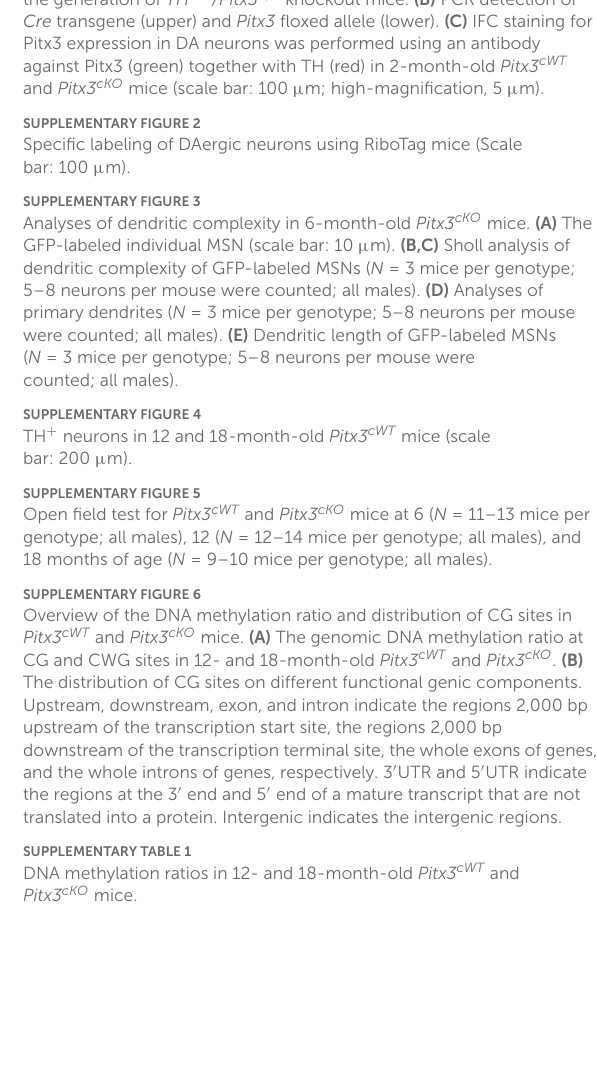
SUPPLEMENTARYFIGURE1 Conditional knockout of Pitx3 in DA neurons. (A) The basic strategy for the generation of TH Cre /Pitx3 fl / fl knockout mice. (B) PCR detection of Cre transgene (upper) and Pitx3 floxed allele (lower). (C) IFC staining for Pitx3 expression in DA neurons was performed using an antibody against Pitx3 (green) together with TH (red) in 2-month-old Pitx3 cWT and Pitx3 cKO mice (scale bar: 100 µ m; high-magnification, 5 µ m). SUPPLEMENTARYFIGURE2 Specific labeling of DAergic neurons using RiboTag mice (Scale bar: 100 µ m). SUPPLEMENTARYFIGURE3 Analyses of dendritic complexity in 6-month-old Pitx3 cKO mice. (A) The GFP-labeled individual MSN (scale bar: 10 µ m). (B,C) Sholl analysis of dendritic complexity of GFP-labeled MSNs ( N = 3 mice per genotype; 5–8 neurons per mouse were counted; all males). (D) Analyses of primary dendrites ( N = 3 mice per genotype; 5–8 neurons per mouse were counted; all males). (E) Dendritic length of GFP-labeled MSNs ( N = 3 mice per genotype; 5–8 neurons per mouse were counted; all males). SUPPLEMENTARYFIGURE4 TH + neurons in 12 and 18-month-old Pitx3 cWT mice (scale